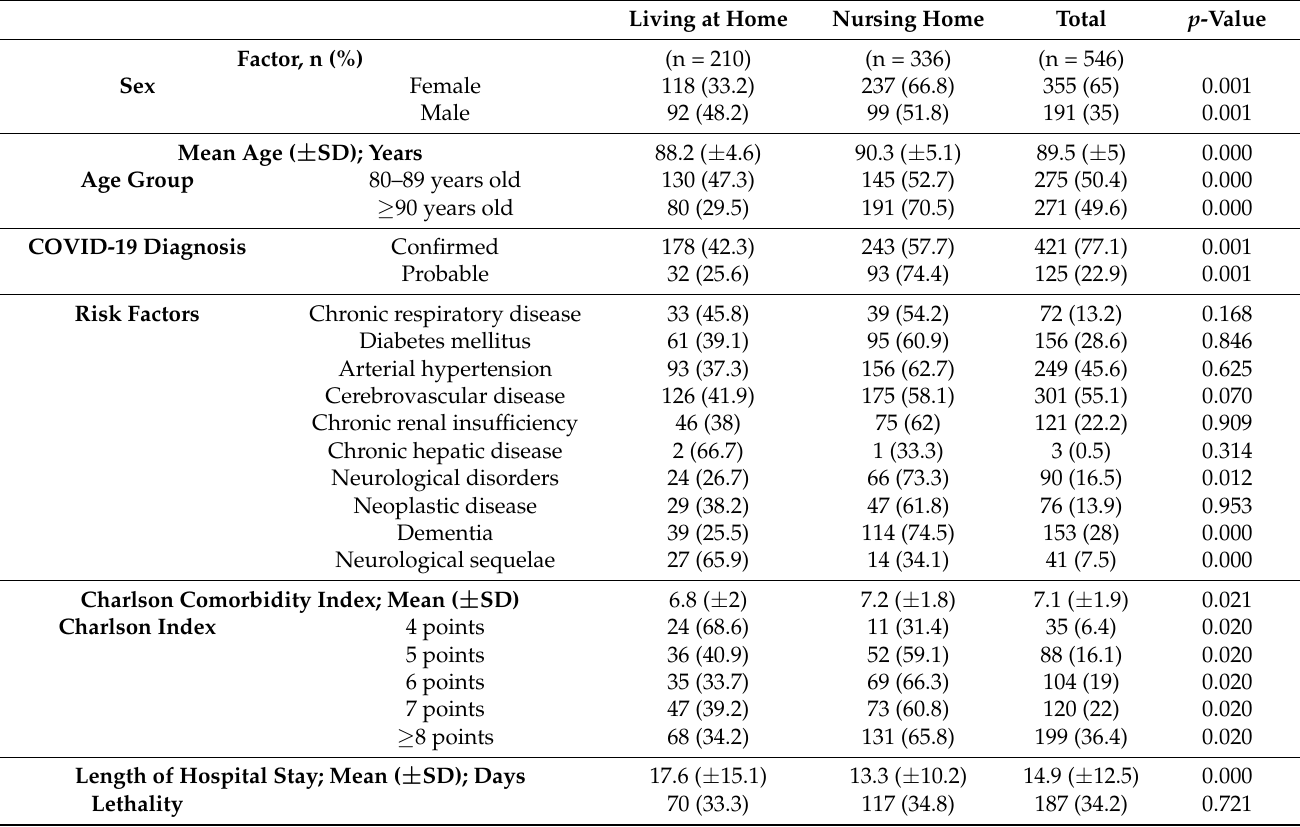
Table 1. Clinical and sociodemographic factors of COVID-19 patients in HCCR, differences between living arrangement (living at home vs. nursing home). Living at